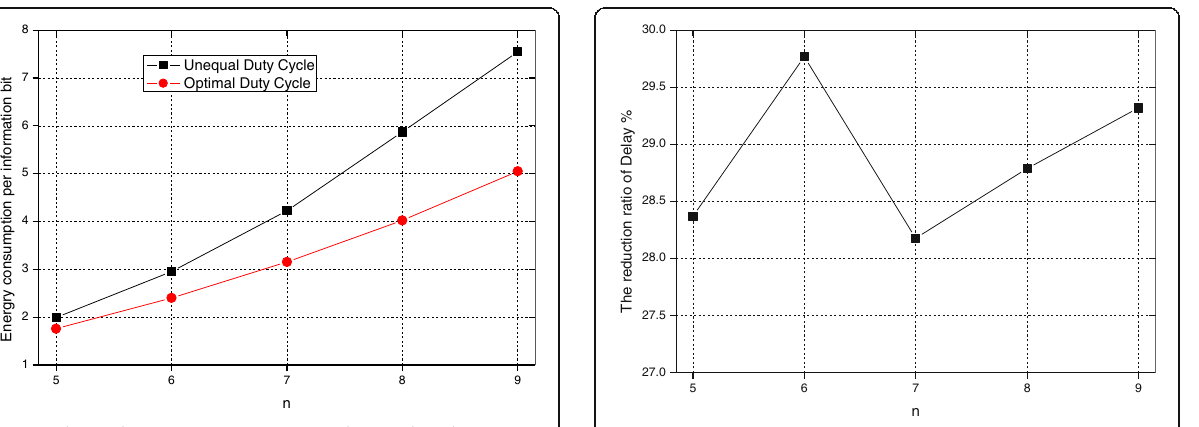
Fig. 31 The total energy consumption in Grid network under UDCNP and OPCNP